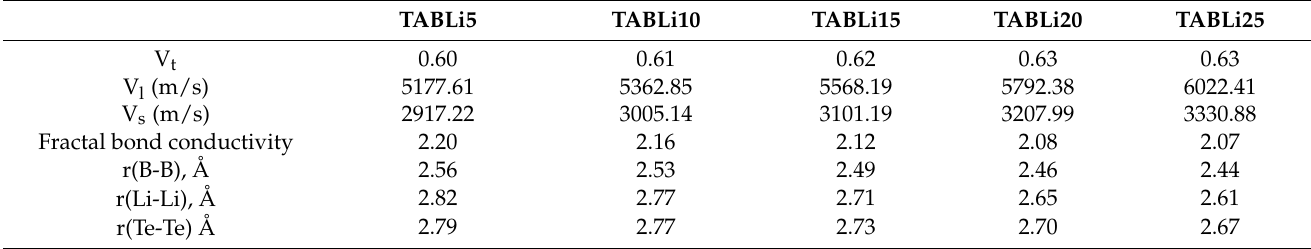
In order to compute the elastic moduli (EM), Young (Y), shear (K), bulk (B), and longitudinal (L), the Makishima–Mackenzie (M–M) model assumptions were ap- plied. Thus, both the investigated TABLi glasses’ dissociation energy (G t ) and backing factor (V i ) were calculated. The G t values were increased by replacing the TeO 2 with Li 2 O compounds. This is attributed to the heat of formation (enthalpy, ∆ H f ) of constituting compounds, where it is − 561.2 kJ/mol for Li 2 O and − 270.3 kJ/mol for TeO 2 . On the other hand, the glasses’ packing factor (V i , cm 3 /mol) was computed for the TABLi glasses with the help of the values of the ionic radius of Te, B, As, Li, and O. Figure 3 displays a reverse relationship between the V i and Li 2 O concentration. The Vi values decreased from 16.55 to 15.215 cm 3 /mol, increasing TeO 2 substitution by Li 2 O. This can be attributed to the replacement of Te ions with a higher ionic radius (R Te = 2.22 Å) by Li ions with a smaller Pauli ionic radius (R Li = 0.56